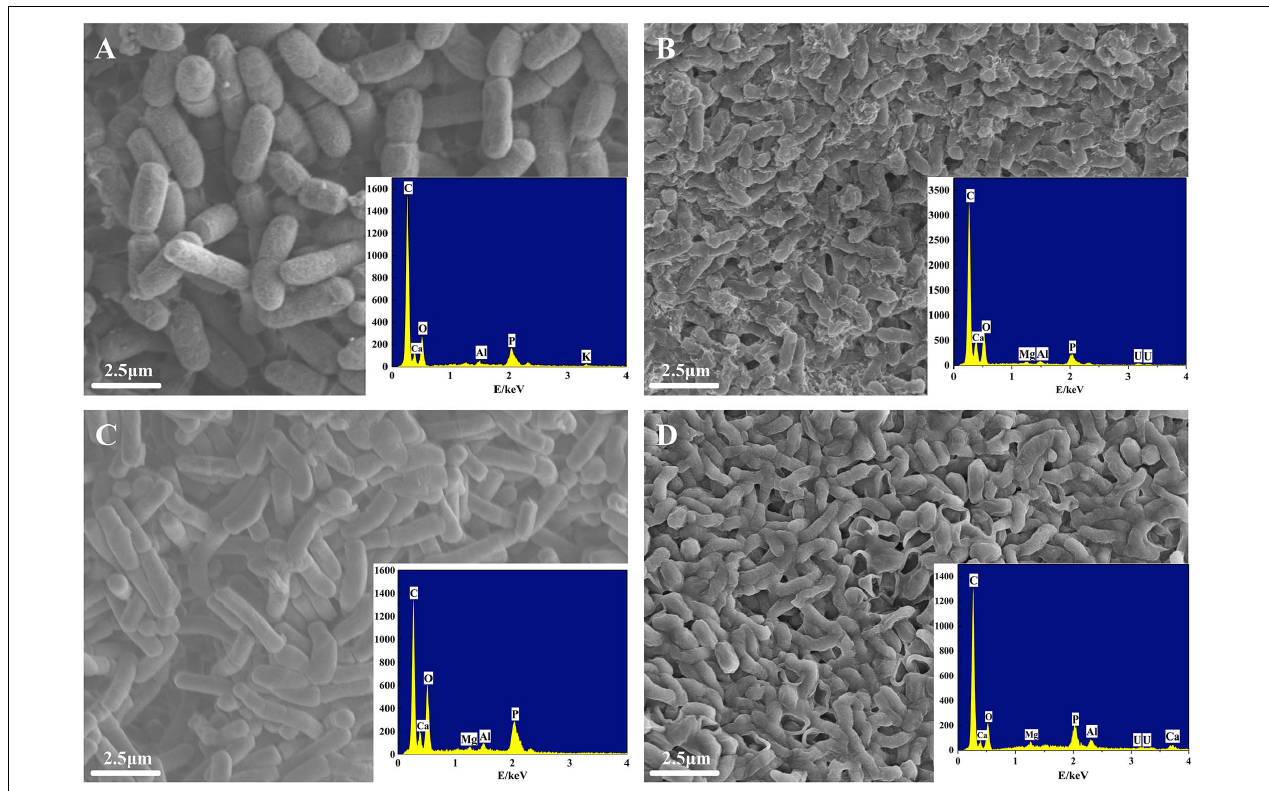
FIGURE 5 | SEM-EDS images of two isolates before and after exposure to U(VI): (A) ZJ-1 before exposure to U(VI), (B) ZJ-1 after exposure to U(VI), (C) ZJ-3 before exposure to U(VI), and (D) ZJ-3 after exposure to